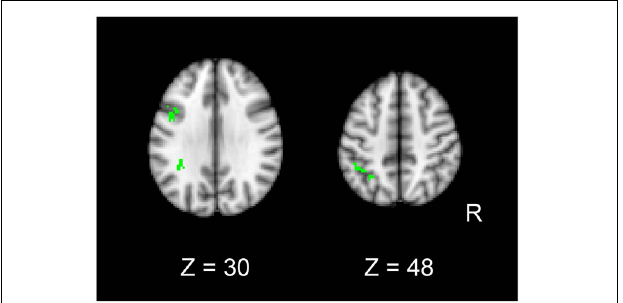
FIGURE 8 | Conjunction maps of the univariate analysis and MVPA for the contrast Mirror-Repeat vs. Plain-Repeat.